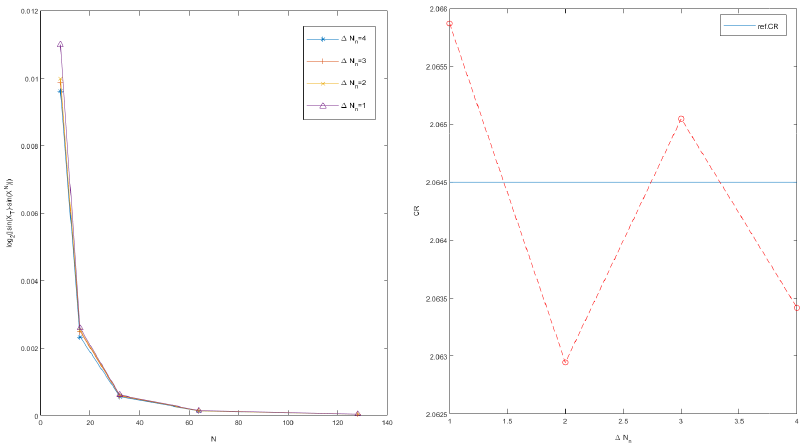
Figure 1. ( Left ) The global errors for Example 3; and ( Right ) the convergence rates of ∆ N n = 1, ∆ N ∆ N ∆ N n = 2, n = 3, and n =